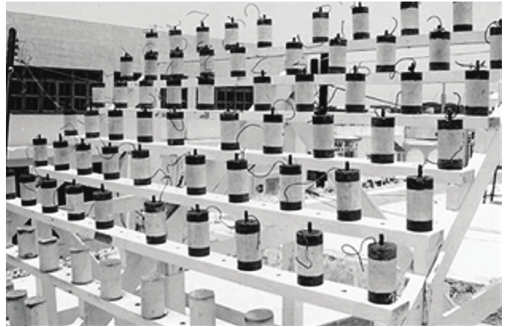
Figure 1: Concrete cylinders exposed to a tropical marine environ- ment 100m from the coast at Progreso, Yucatan, M´exico (21 ∘ 18 󸀠 N, 89 ∘ 39 󸀠 W).